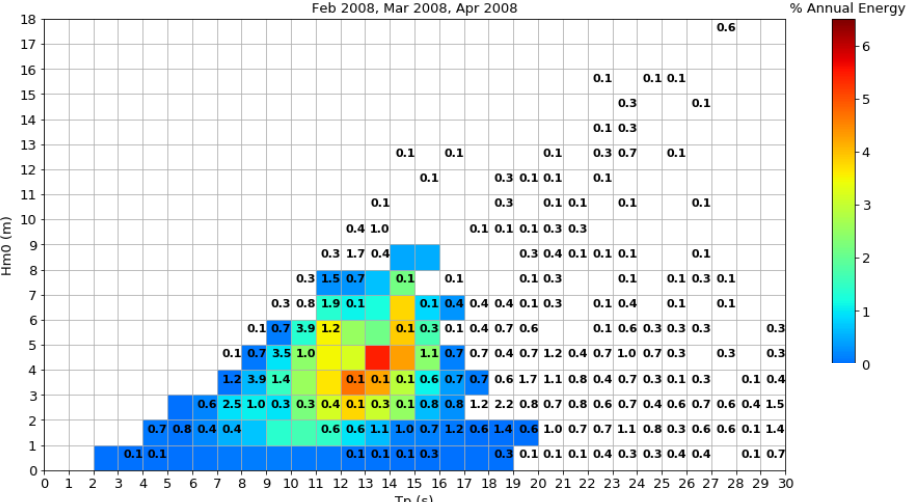
Fig 6. Scaled up Melvaig Peninsula ( H m0 , T p ) % occurrence scatter table (tabulated numbers) for Feb-Apr 2008 overlaid on Billia Croo ( H m0 , T p ) % annual incident energy scatter colour map for 2008.